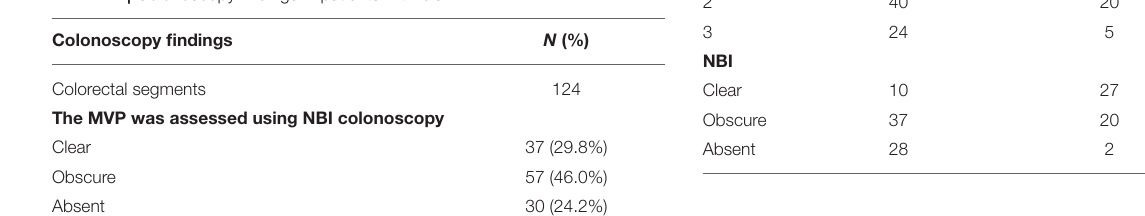
TABLE 2 | Colonoscopy findings in patients with UC.